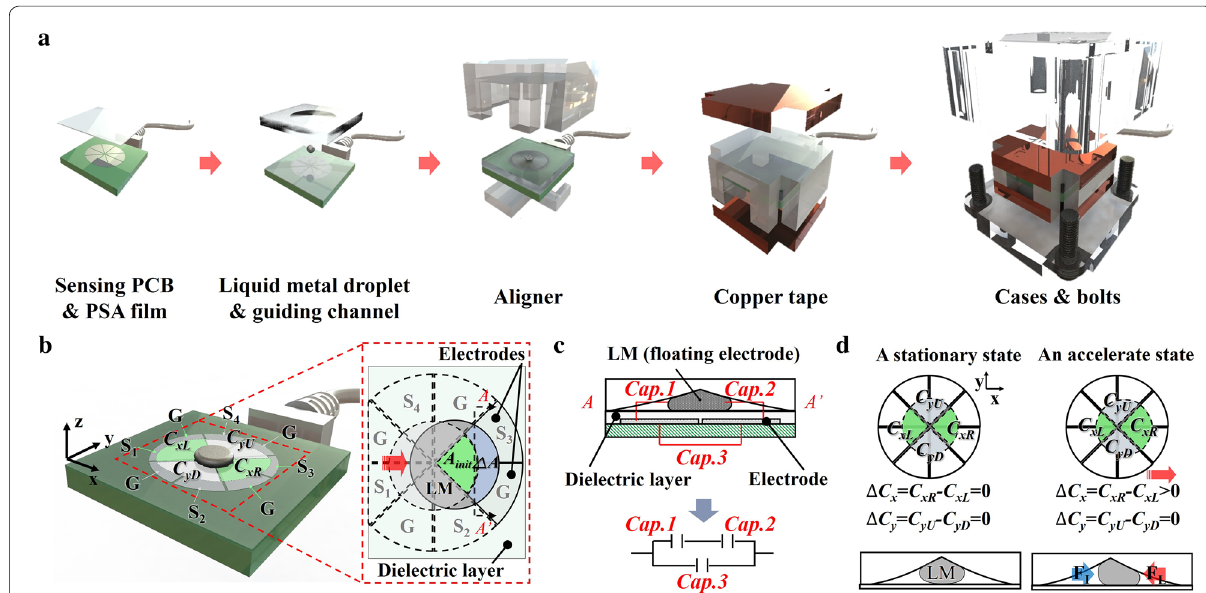
Fig. 1 Configuration and sensing principle of the device. a The fabrication process of the device. b Configuration of the sensing electrode. c Cross‑sectional view of AA ′ . Schematic diagram showing the relationship of each capacitance value (i.e., Cap.1 , Cap.2 , and Cap.3 ). d Capacitance variations according to acceleration in the x